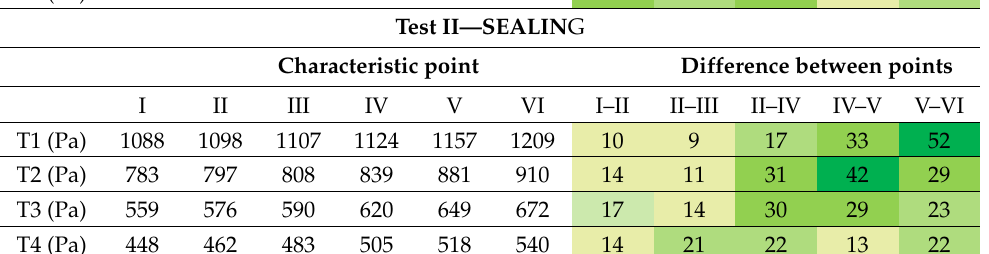
table omits a few seconds of sealing and unsealing around 1405 s: I—duct before unsealing, II—first leakage between T5 and T4, III—second leakage between T5 and T4, IV—third leakage between T4 and T3, V—fourth unsealing between T3 and T2, VI—fifth leakage